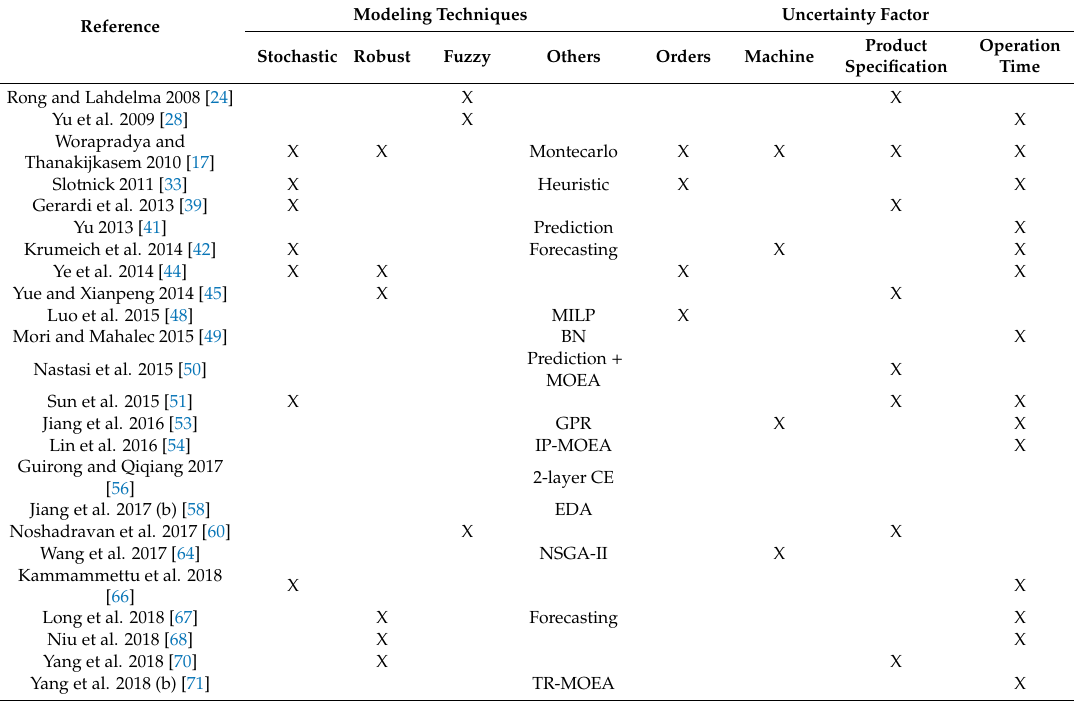
Table 3. Proactive scheduling models in steel